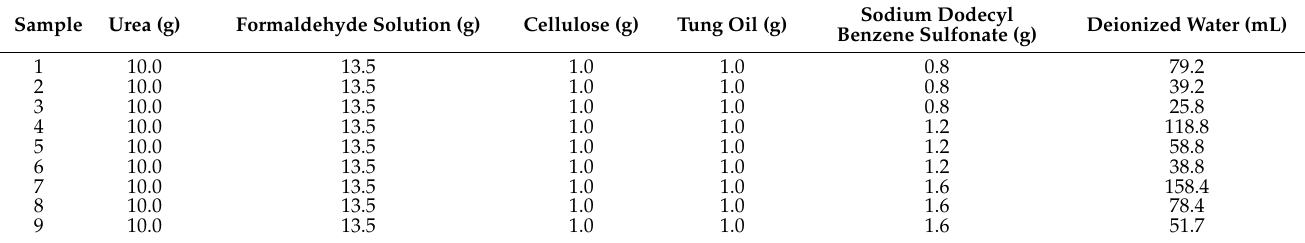
Table 3. List of materials prepared for the microcapsule